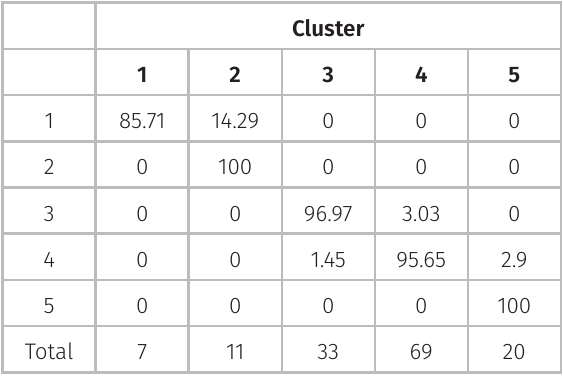
Clusters: 1 - Highest Impact ; 5 – Lowest